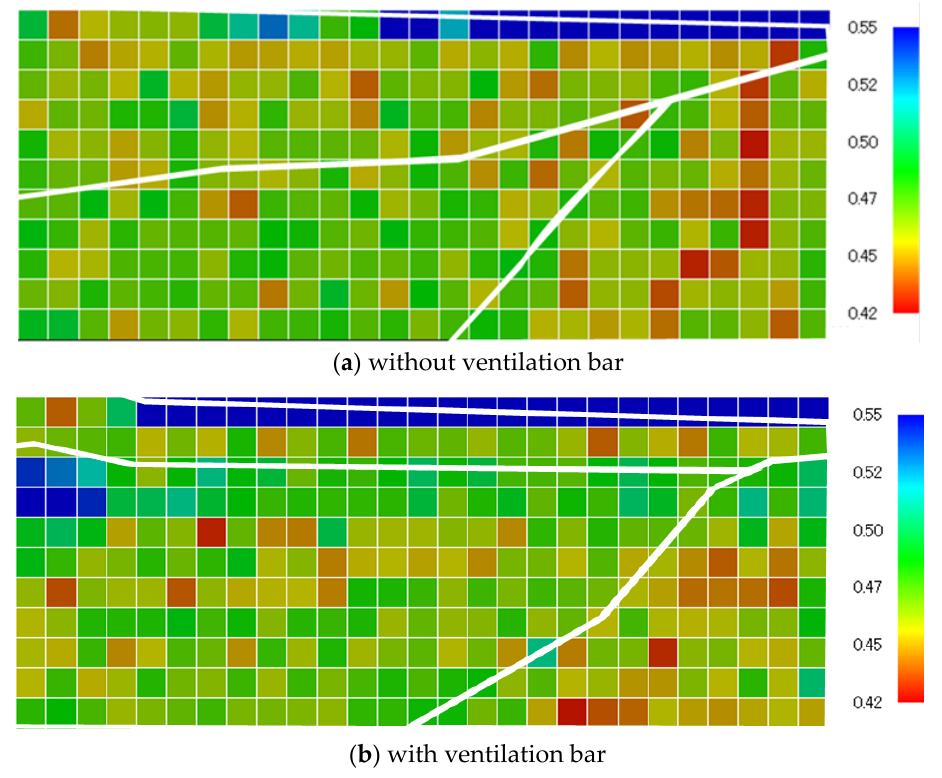
Figure 7. Classification of packing structures with different characteristics in the sinter bed: ( a ) without, ( b ) with ventilation bar.